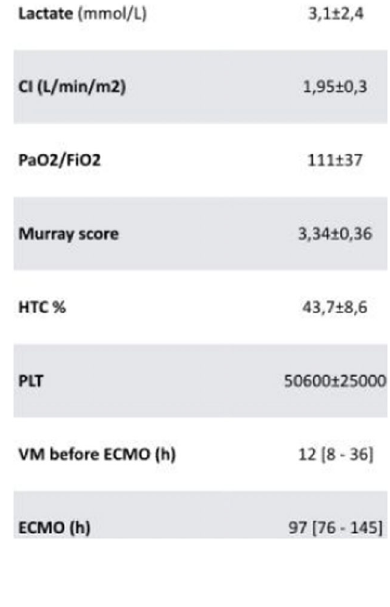
Table 2 (abstract 000914). Baseline characteristic before ECMO